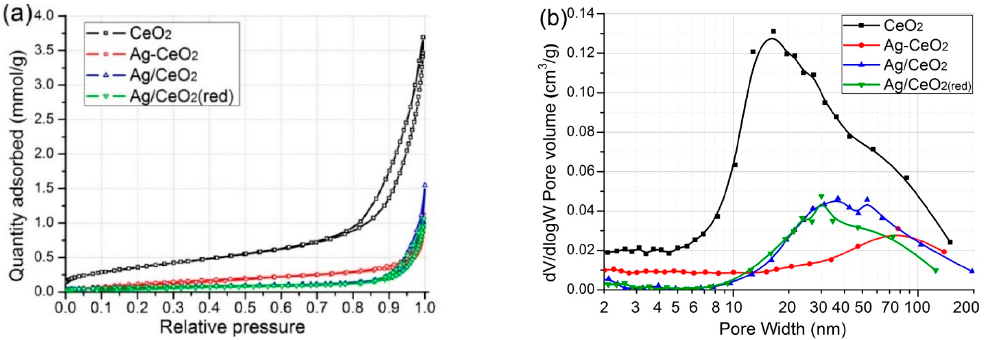
Figure 1. The isotherms of N 2 adsorption-desorption ( a ) and the corresponding pore size distributions (BJH-Desorption method) ( b ) for CeO 2 and catalysts.